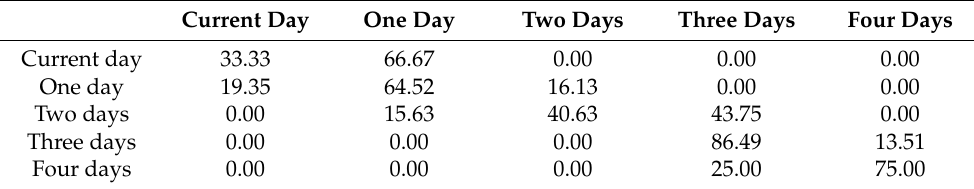
Table 4. Prediction results obtained using the average of the differences between R and G in RGB values without noise.